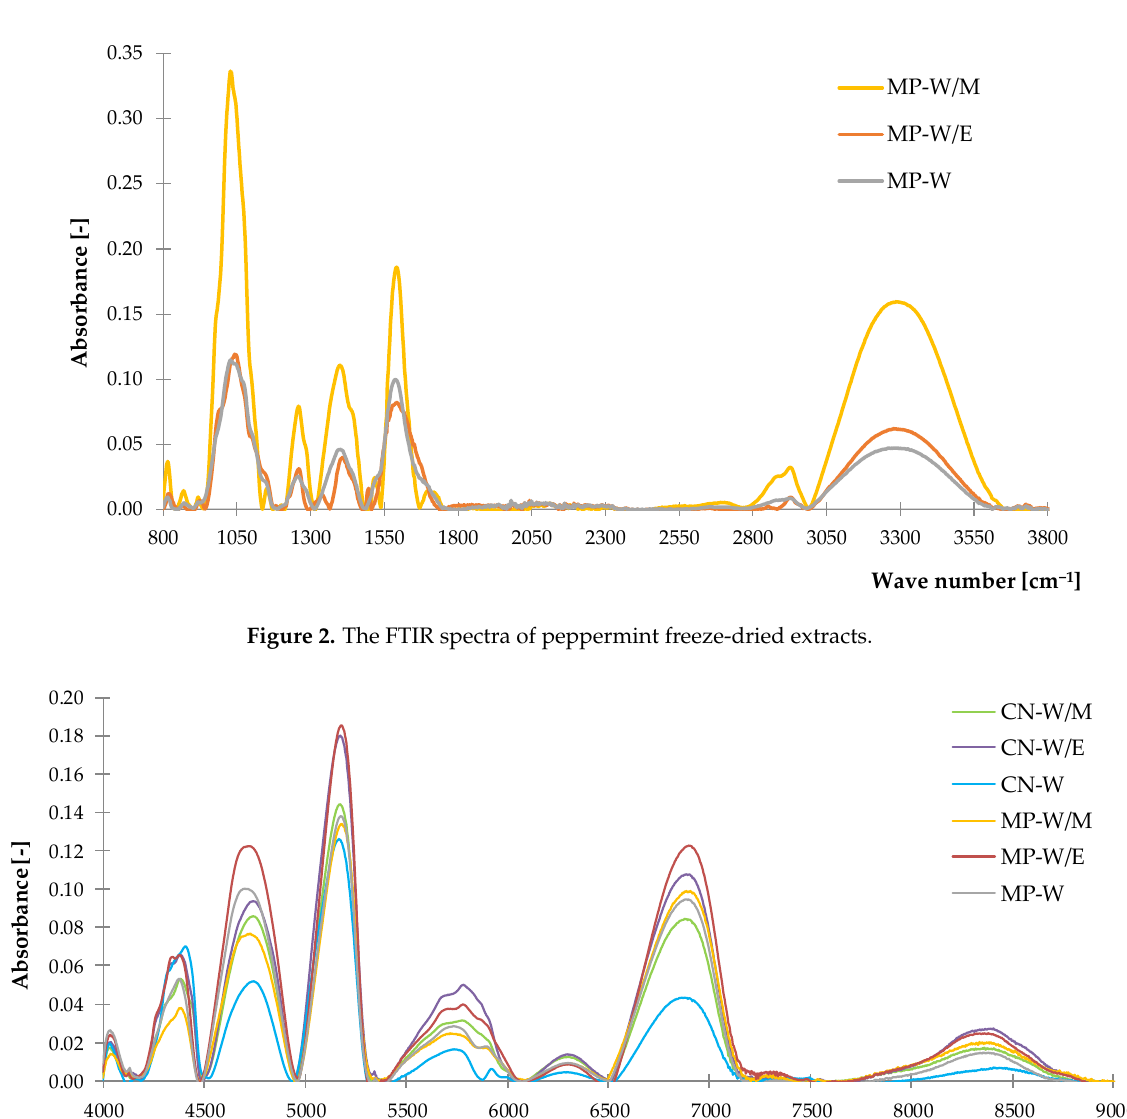
Figure 1. The FTIR spectra of common nettle freeze-dried extracts.